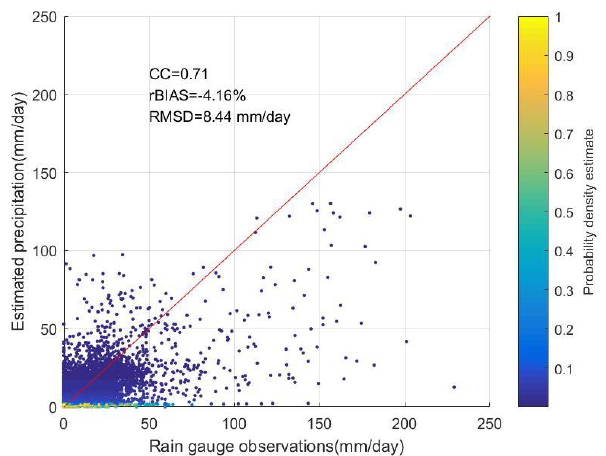
Figure 9. Scatter plots with color density showing rain gauge observation and the estimated precip- itation by the GWR model for fusion in 2015.